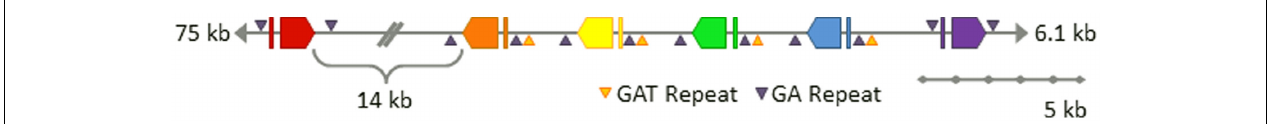
FIGURE 8 | Six Sp185/333 genes are linked on the 7096 BAC insert. The finished-level assembly of the region containing the Sp185/333 genes was experimentally confirmed by PCR, pulsed field gel electrophoresis, Ase I digests, and subclone sequences.The six Sp185/333 genes include one gene with the A2 element pattern (red), one B8 gene (orange), three D1 genes (yellow, green, blue), and one E2 gene (purple; see Figure for element